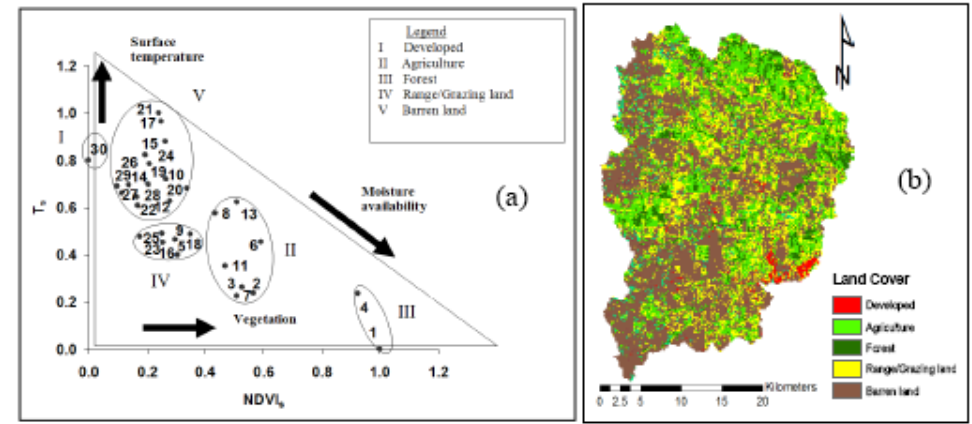
Figure 5. Land cover mapping: (a) Scattergram of NDVI vs surface temperature (b) Land cover classes of Heart River sub-basin, Missouri River